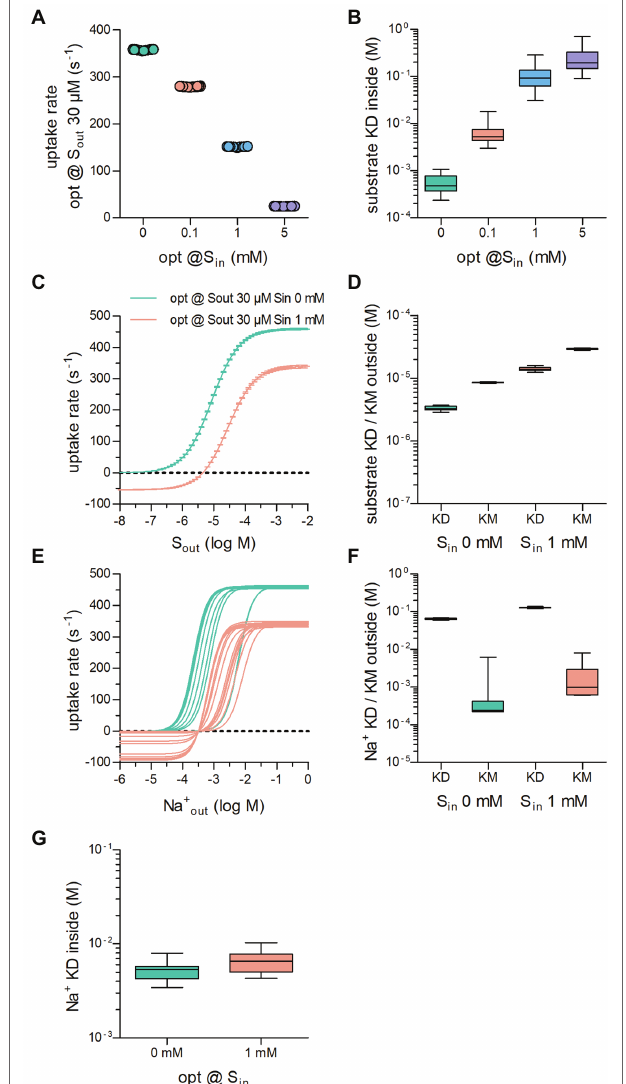
FIGURE 3 | The optimized substrate uptake rate depends on the intracellular substrate concentration (S in ). (A) Plotted are the optimized substrate uptake rates for transporters operating according to the NaSNaS scheme. S out was set to 30 μ M in all optimization runs. The data show the substrate uptake rate of transporters optimized for 0 mM, .1 mM, 1 mM, and 5 mM S in , respectively. The rate decreased with rising S in . Twenty optimization runs were carried out for each condition. (B) Shown is the K D of substrate binding to the inward-facing conformation of transporters in (A) . The K D decreased as S in increased. (C) The curves show the substrate uptake rate as a function of S out of transporters optimized for 0 mM (green) and 1 mM S in (magenta). In the presence of S in , the substrate uptake rate assumed negative values when S out was low. In this range of S out , the transporters cycled in the reverse direction. In the presence of 1 mM S in, V max was reduced. (D) Plotted are the K D values for substrate binding to the outward-facing conformation of the transporter and the corresponding K M values of transporters optimized for 0 mM S in and for 1 mM S in . At high S in both the K M and the K D values rose. The coefficients of variation for the K D s were .080 and .070 and for the K M s .020 and .026 at .1 μ M and 100 μ M S out , respectively. (E) Shown is the concentration dependence of the substrate uptake rate